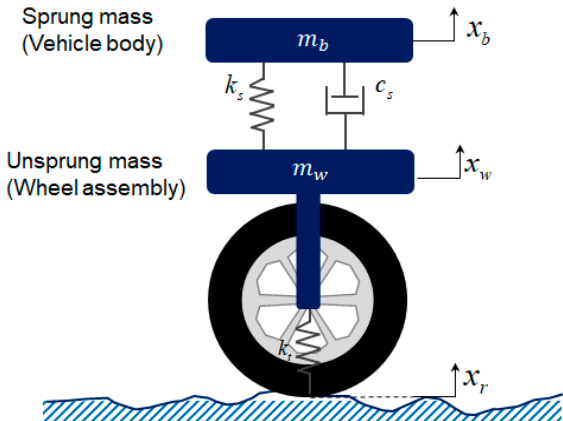
Figure 2. Schematic of quarter-car suspension system consisting of two primary masses (sprung and unsprung).